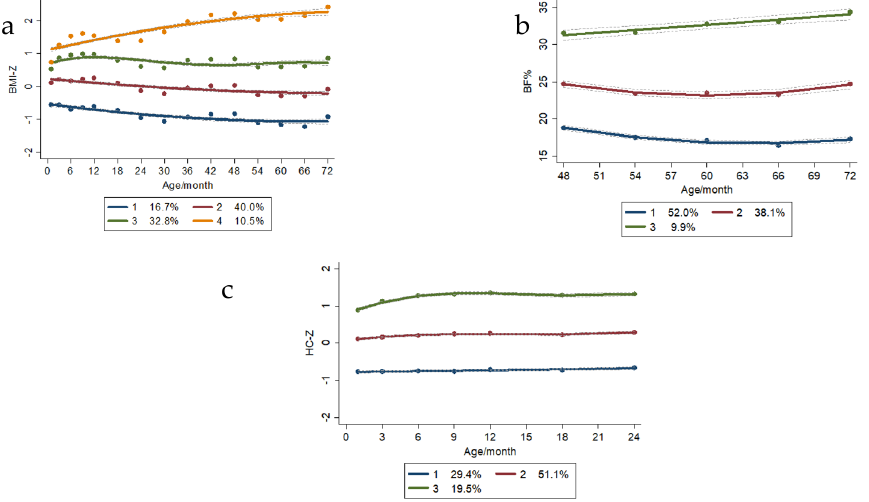
Figure 3. Children’s physical development trajectory. ( a ) BMI − z trajectory; ( b ) Body fat ratio trajectory; ( c ) HC − Z trajectory.